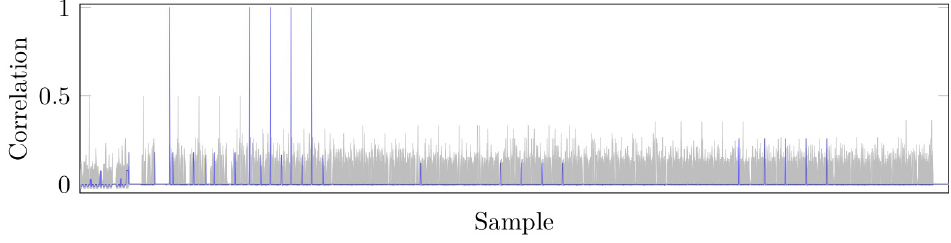
Figure 5: Collision attack traces on the NSC variant for the good key guess (in blue) and for 256 (out of 2 16 − 1) incorrect key (in